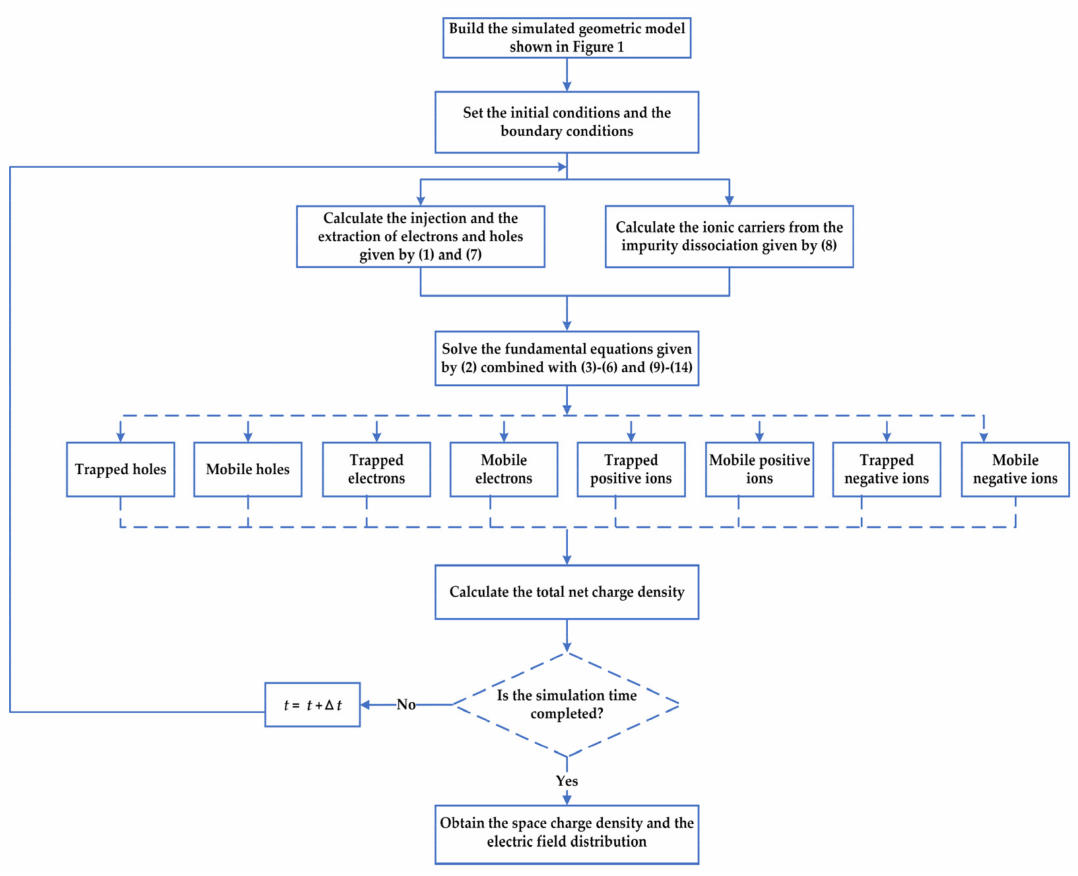
Figure 1. The flow chart of the simulation